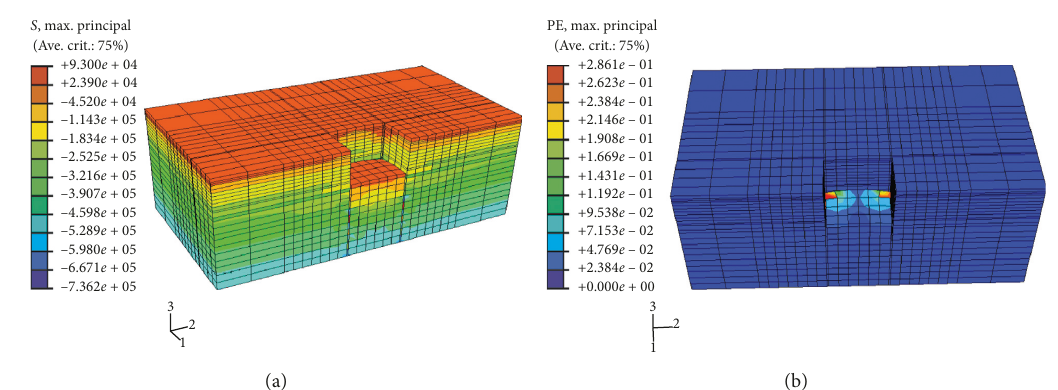
Figure 6: (a) The maximum principal stress of soil adjacent to the pit. (b) Soil plastic strain adjacent to the pit.